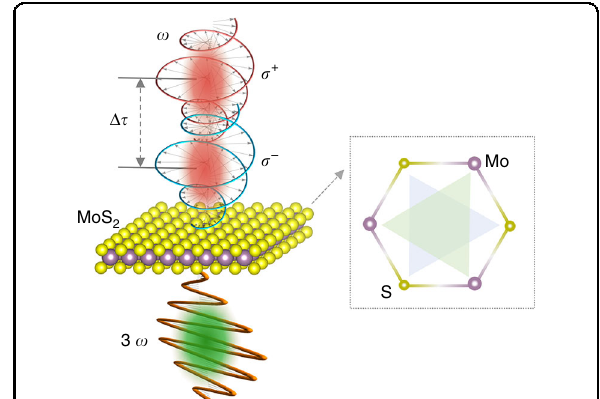
Fig. 1 Schematic illustration of coherent modulation of THG with chiral light. The spatially overlapped two incident beams with opposite circular polarization states ( σ − and σ + ) at the same frequency of ω lead to modulated THG at a frequency of 3 ω as a function of the time delay ( Δ τ ) in monolayer MoS 2 (acting as modulator). Inset is the top view of the crystal structure of monolayer